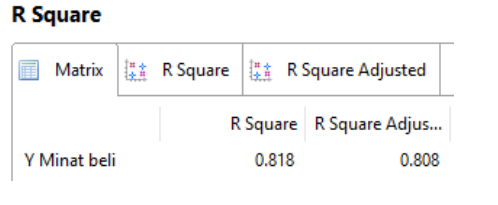
Table 3.Inner Test of R-Square Model